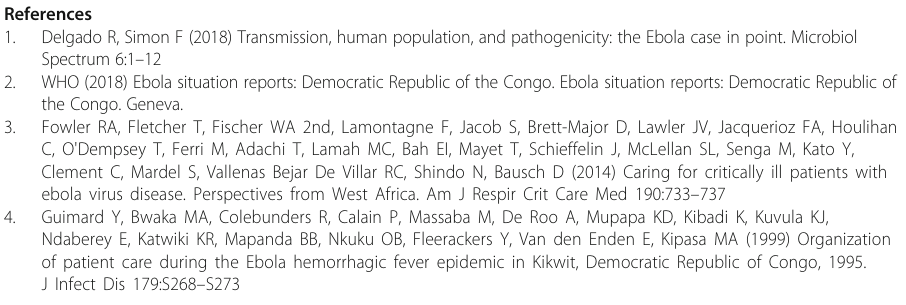
Additional file 2: Figure S1. Vitals Signs over Time for the Uninfected Animal. Trends in vital signs over time for the uninfected animal. Heart rate (in beats per minute) and systolic/diastolic blood pressure (in mmHg) are plotted on the left Y-axis. Temperature is plotted on the right Y-axis. (TIF 575